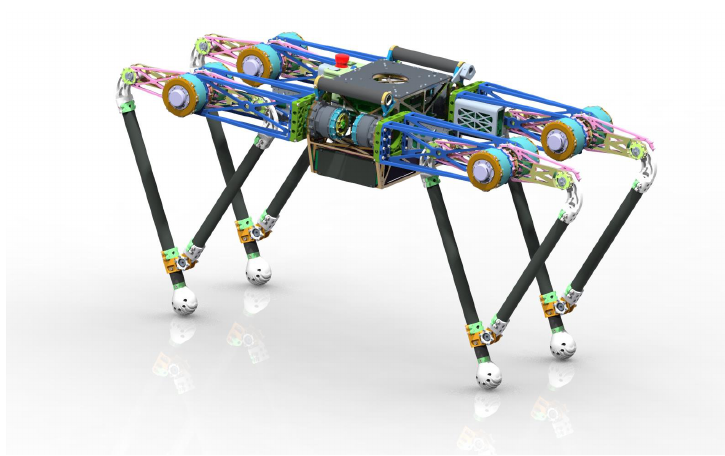
Figure 1. The BQR-2